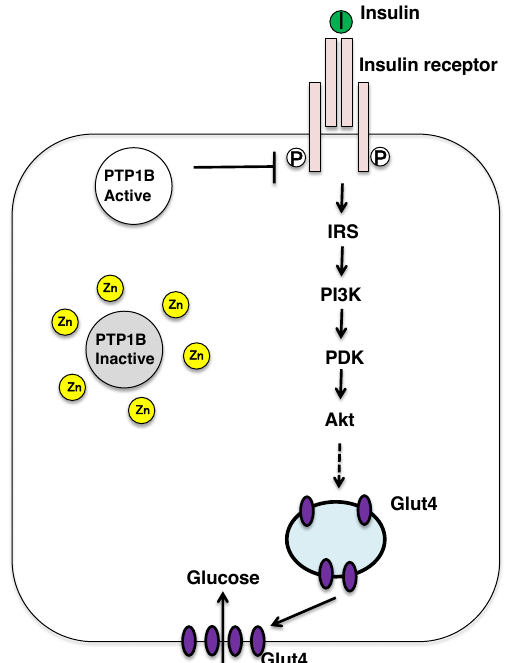
Figure 3. Insulin signaling pathway and insulin mimicking function of zinc ions. Insulin binds to the insulin receptor located in the plasma membrane in the peripheral tissues, such as liver and muscle. The insulin-signaling pathway is activated and the glucose transporter GLUT4 is translocated to the plasma membrane. Zinc might inhibit the activity of PTP1B, which activates the insulin-signaling pathway. PI3K, phosphatidylinositol-3-kinase; IRS, insulin receptor substrate; PKD, protein kinase